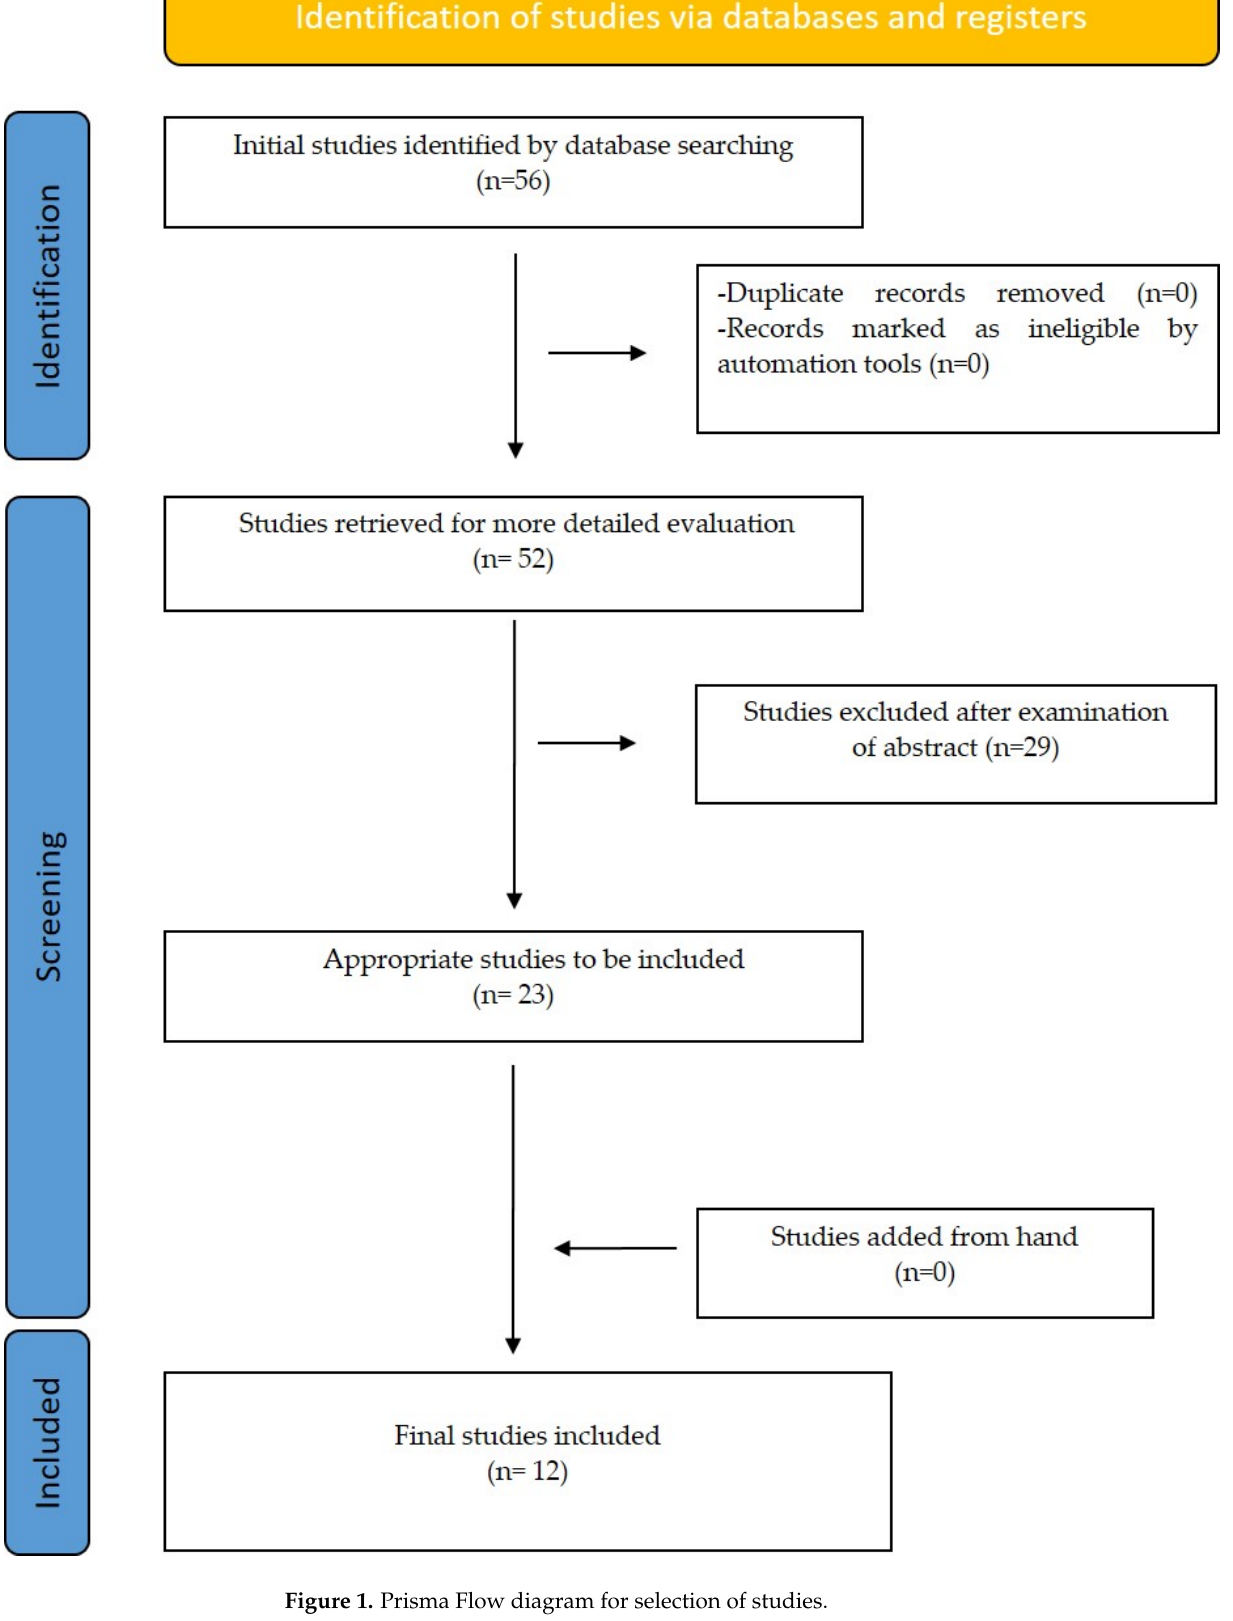
Figure 1. Prisma Flow diagram for selection of studies.